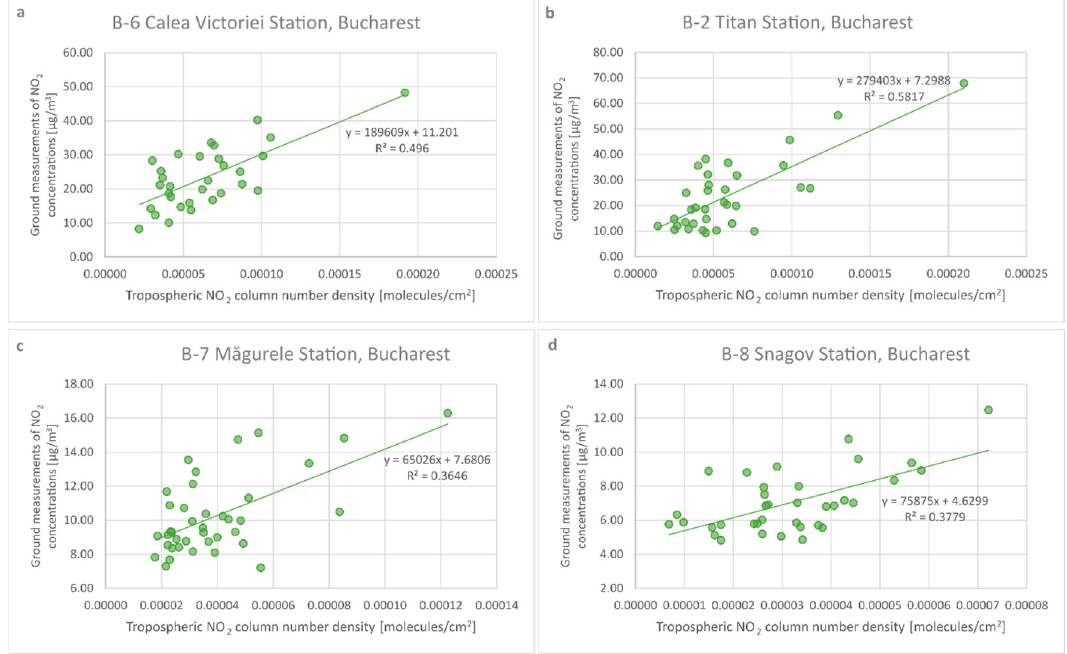
Figure 11. Data correlation between satellite-based tropospheric NO 2 column number density derived from TROPOMI (S-5P) L3 products and ground-based measurements of NO 2 concentrations for various monitoring stations in Bucharest classified as follows: urban traffic ( a ), urban background ( b ), suburban ( c ), and rural ( d ).